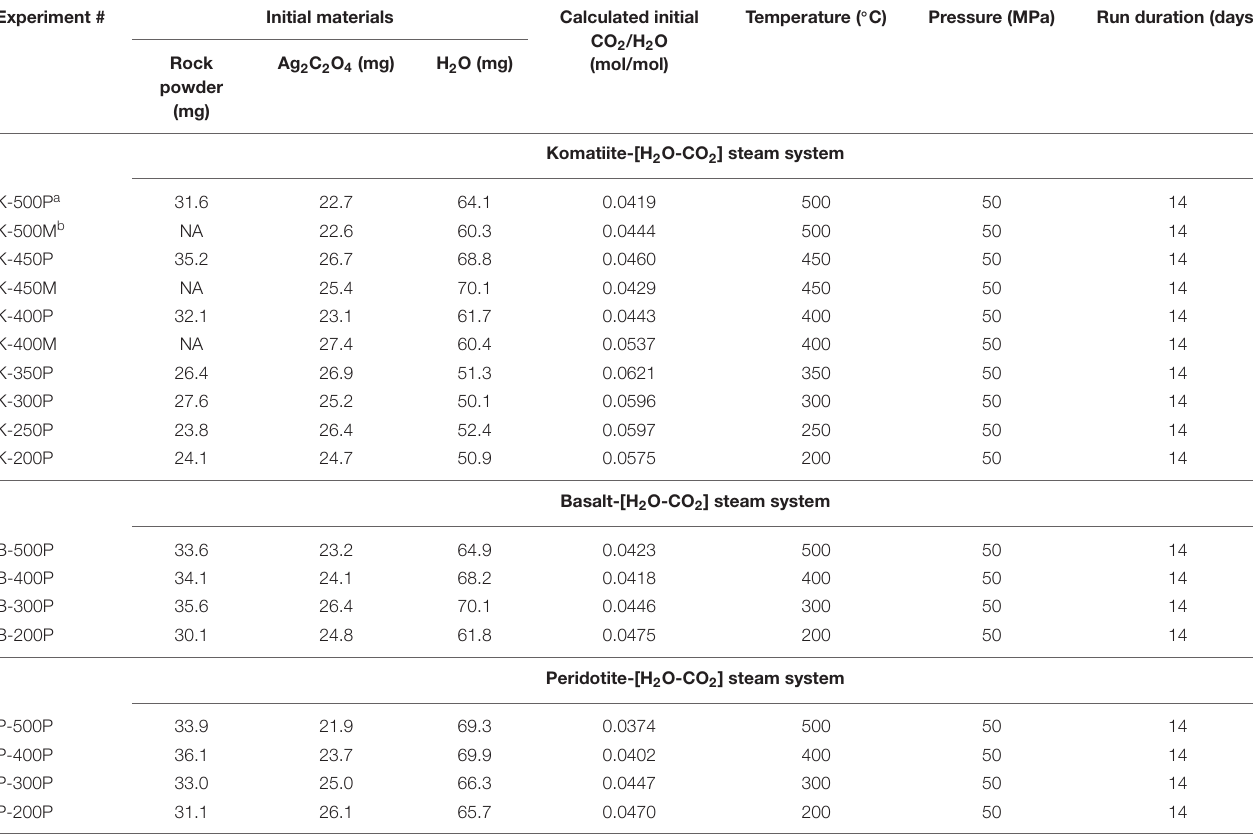
TABLE 1 | Summary of the initial experimental conditions of batch experiments. Experiment # Initial